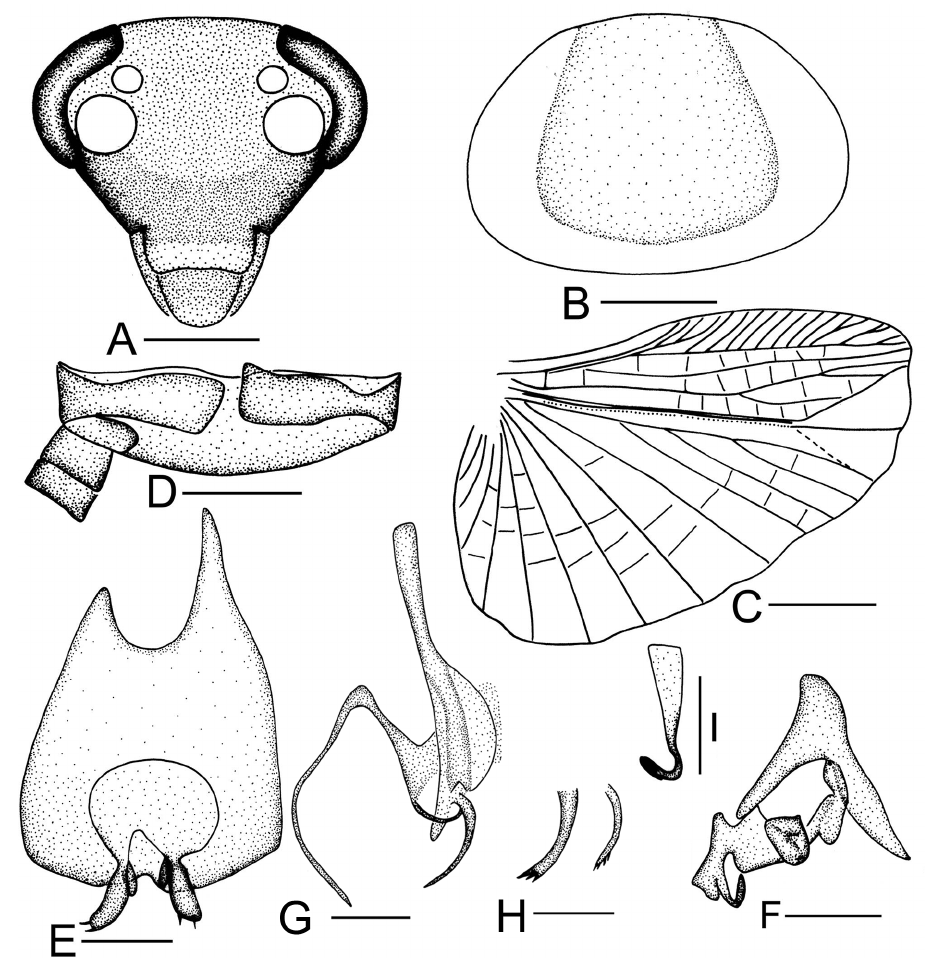
Figure 3. Sorineuchora nigra (Shiraki, 1908). A–G, I male from China, Chongqing, Wanzhou H male from China, Chongqing, Mt. Jinyunshan and China, Chongqing, Mt. Bishan Qinglong Lake A head, frontal view B pronotum C hind wing (the dotted line indicates wing fold) D supra-anal plate, ventral view E subgenital plate, dorsal view F phallomere L1 G phallomere L2vm and R3 H phallomere L2vm I phallomere R2. Scale bars: 0.5mm ( A, D–I ), 1.0 mm ( B ), 2.0 mm ( C ). Female. Some individuals are similar to the male in color and habitus, but supra- anal plate symmetrical with hind margin rounded and subgenital symmetrical with hind margin rounded and slightly concave medially. Some individuals do vary dis- tinctly in body color (Fig. 10C) (body brownish red). Head brownish yellow, ver- tex with a yellowish brown stripe. Clypeus yellowish brown. Wing veins white, legs brown, trochanter yellowish brown, abdominal brown, posterior and lateral margins milk white. We analyzed COI gene sequences of the exceptional female